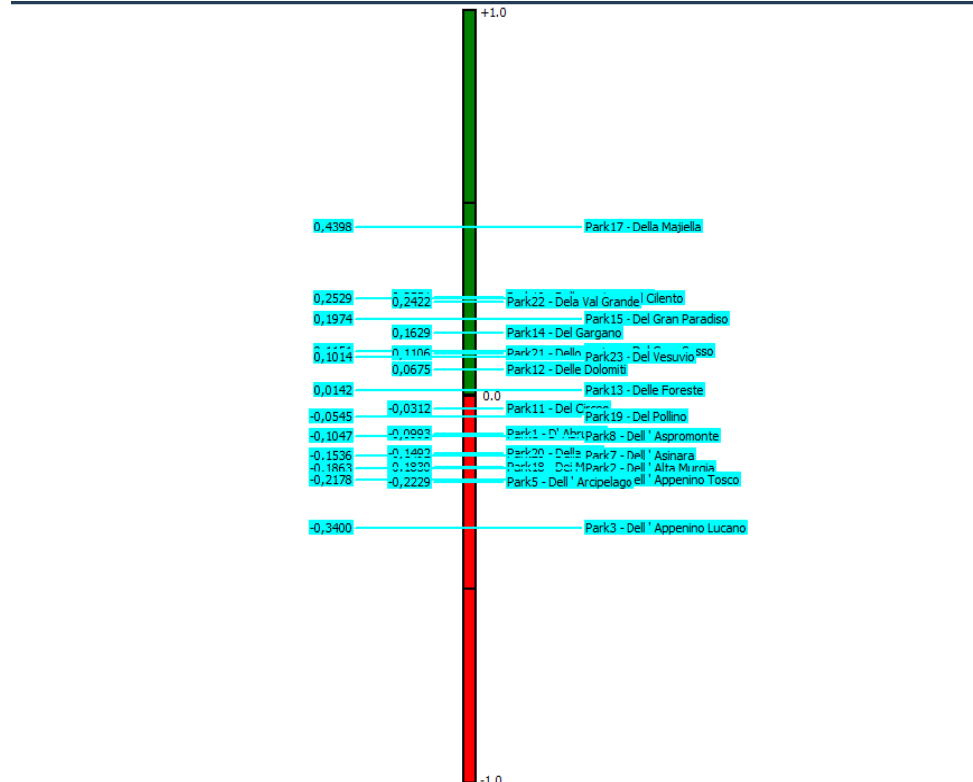
Figure 2. Graphic depiction of the quality of websites. Table 4. Values and Ranking for all websites using SAW, WPM, TOPSIS and PROMETHEE II.